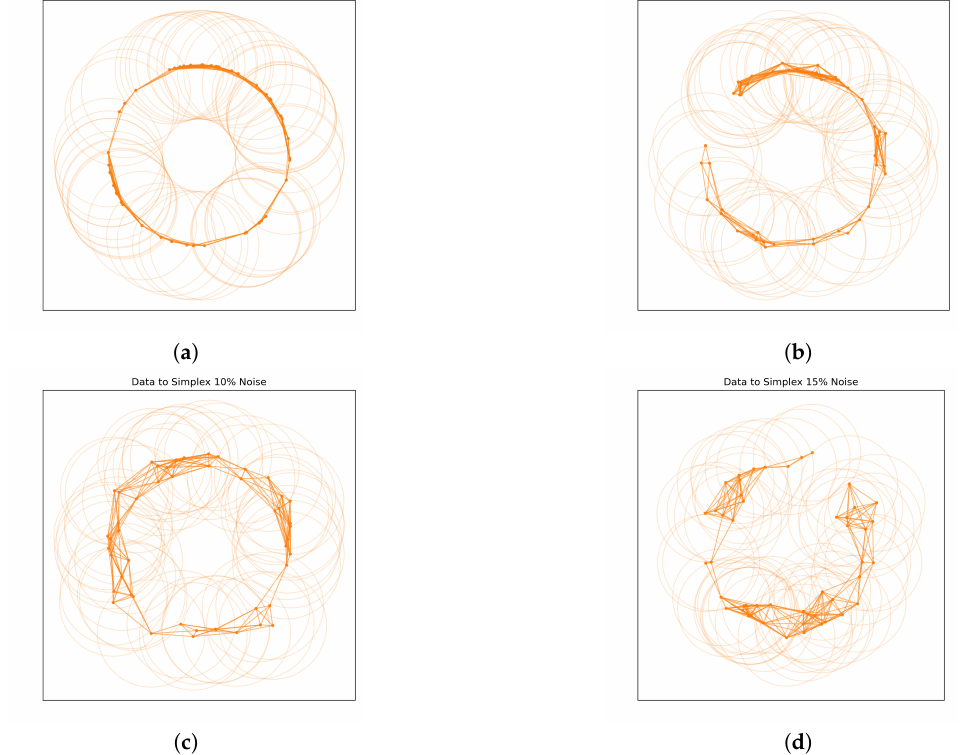
Figure 4. Example of different noise level with same first Betti number 1. ( a ) Noise Level 0, ( b ) Noise Level 5, ( c ) Noise Level 10, ( d ) Noise Level